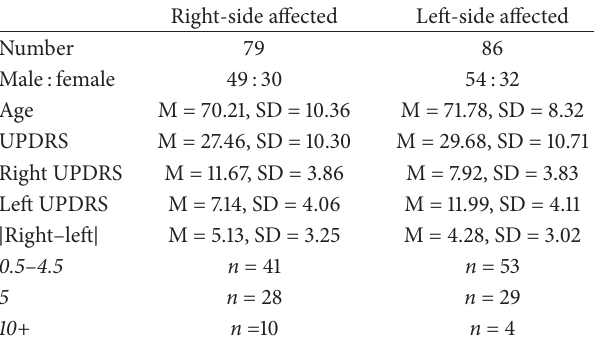
Table 1: Demographic characteristics of participants with